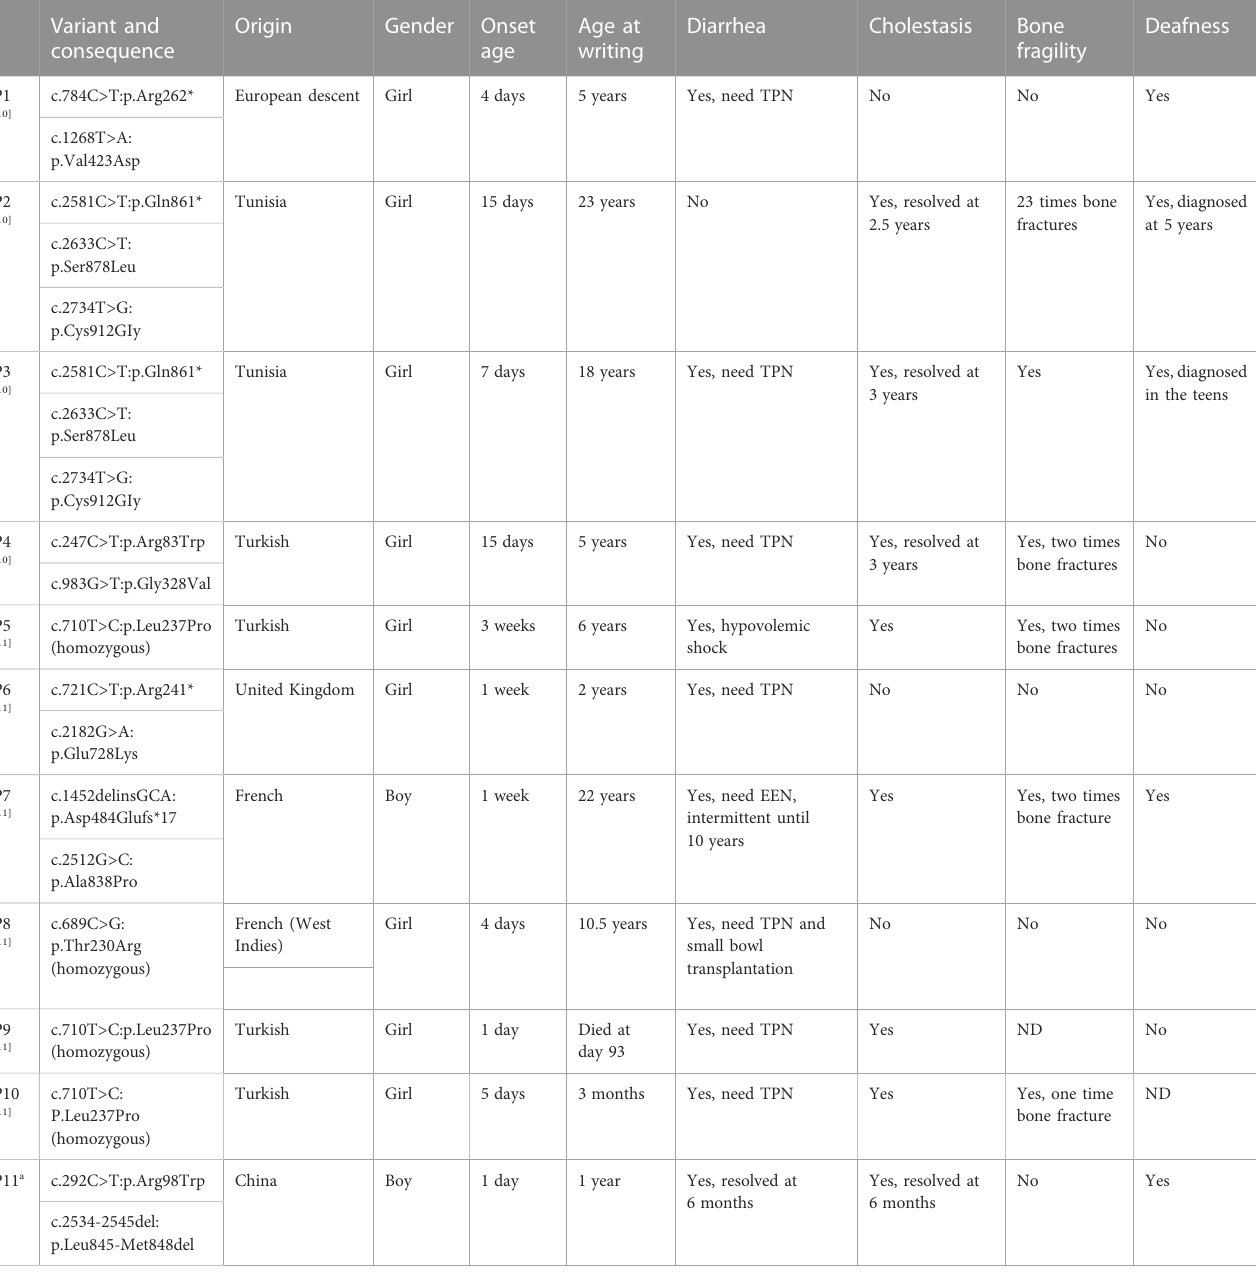
TABLE 2 Summary of clinical and genetic features of mutations in the UNC45A leading to O2HE. Variant and